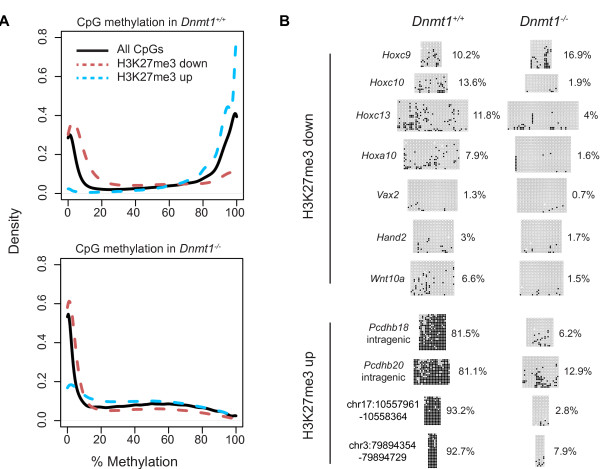
H3K27me3 redistribution in hypomethylated cells is associated with DNA methylation pattern. (A) Density plots showing the methylation of CpGs in Dnmt1+/+ (upper) and Dnmt1-/- (lower) MEFs. The methylation is plotted for all CpGs, CpGs within H3K27me3 down regions and H3K27me3 up regions defined by ChIP-seq. (B) Bisulfite sequencing of selected H3K27me3 down and H3K27me3 up regions in Dnmt1+/+ and Dnmt1-/- MEFs. Filled circles (black) represent 5mCpG and open circles represent CpG. Gaps indicate inconclusive base calling at a CpG site. The overall amount of 5mCpG as a percentage of total CpG in each amplicon is shown adjacent to each image. H3K27me3 down regions represent proximal promoter regions while H3K27me3 up regions represent intragenic or intergenic regions.